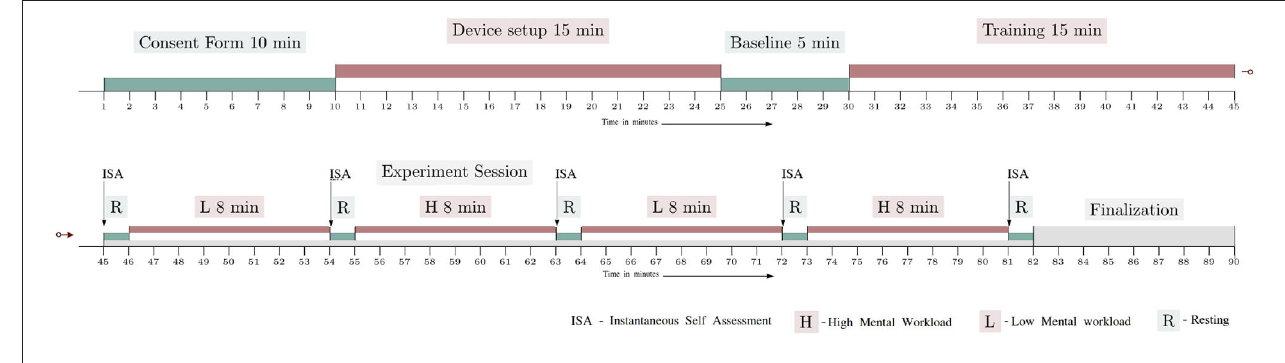
FIGURE 1 | Experimental protocol